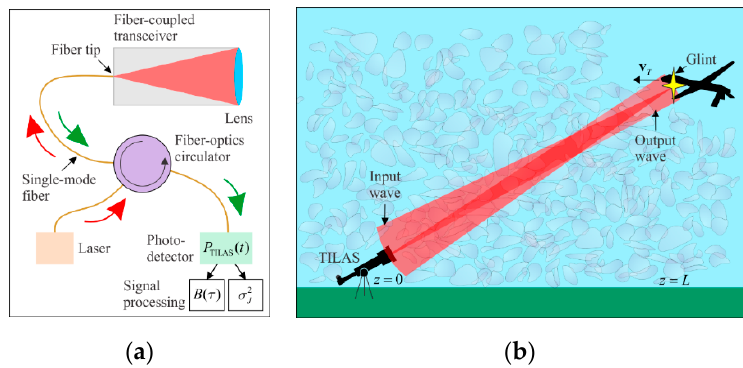
Figure 1. ( a ) Schematic of the TILAS transceiver; ( b ) schematic illustration of the TILAS system operating with a target with a glint, moving with velocity v T